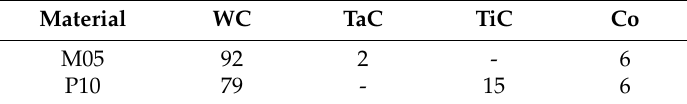
Table 2. The chemical composition of M05 and P10 hard alloys,